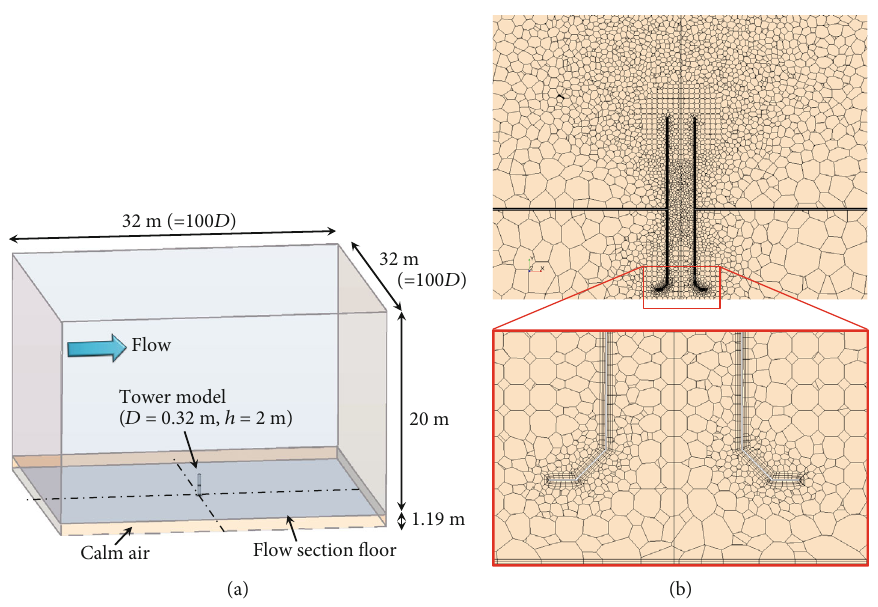
Figure 4: The numerical domain: (a) a schematic of the calculation domain; (b) the computational grid.